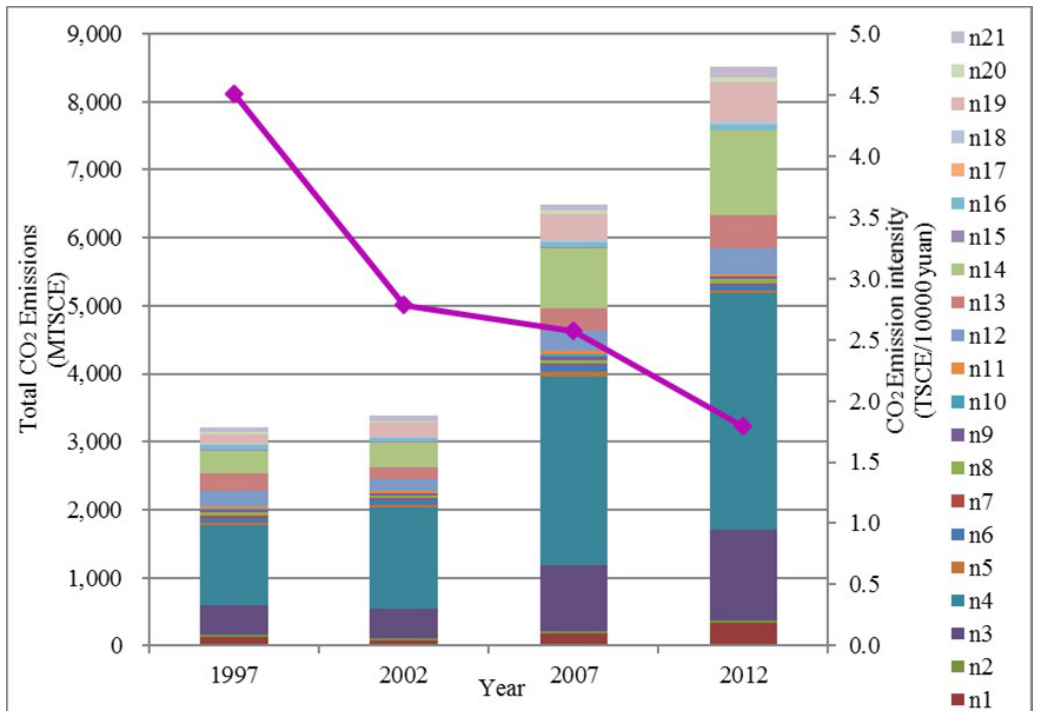
Figure 2. China’s production-based CO 2 emissions (left axis, bars) and total emission intensity (right axis, diamonds). The notations n1–n21 are the abbreviations for China’s 21 sectors, with detailed descriptions presented in Table 3.